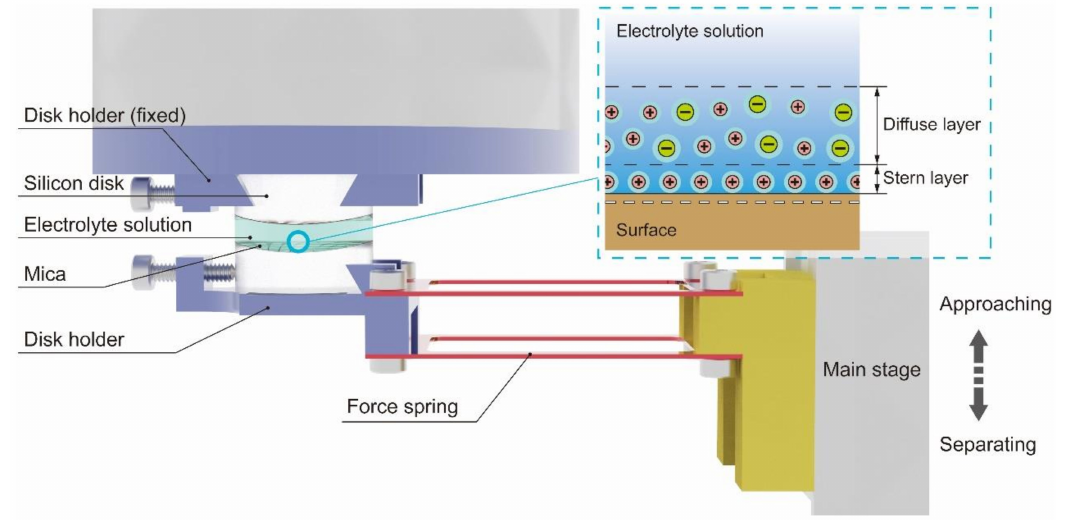
Figure 1. Schematic diagram of the surface forces apparatus (SFA) system. The electric double layer (EDL) structure formed on a mica surface (both the Stern layer and the di ff use layer) is illustrated in the upper right